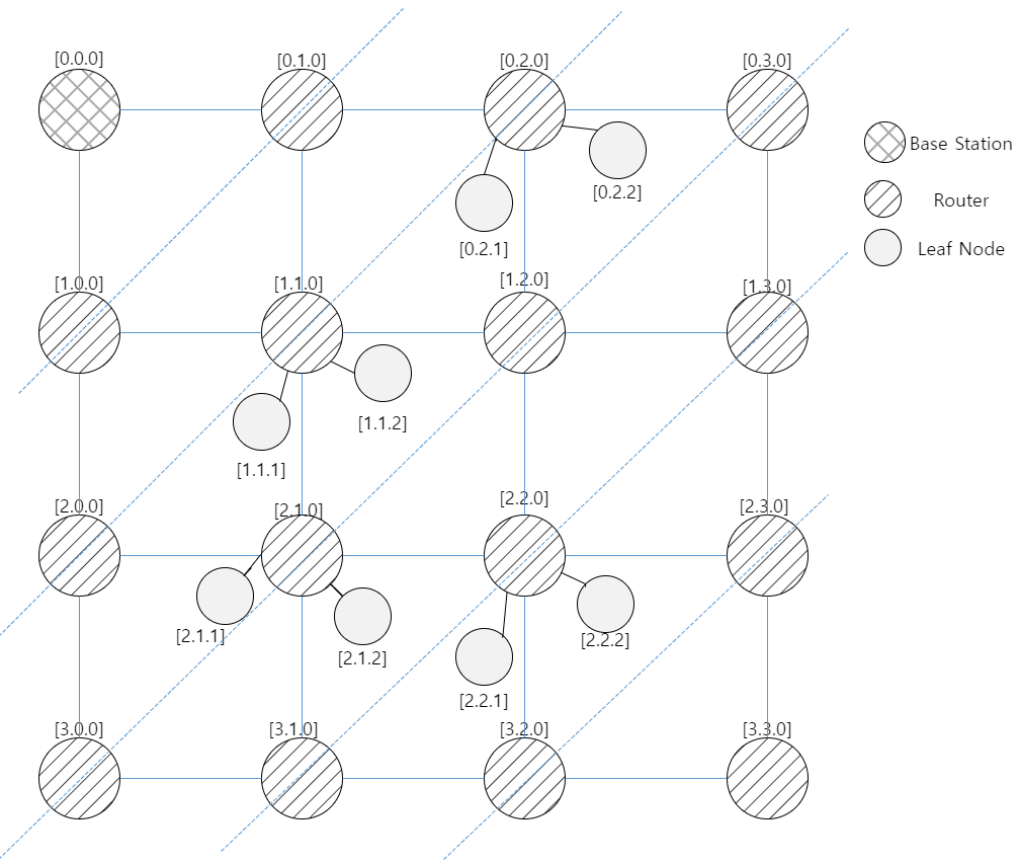
Figure 4. Proposed network address-allocation scheme.